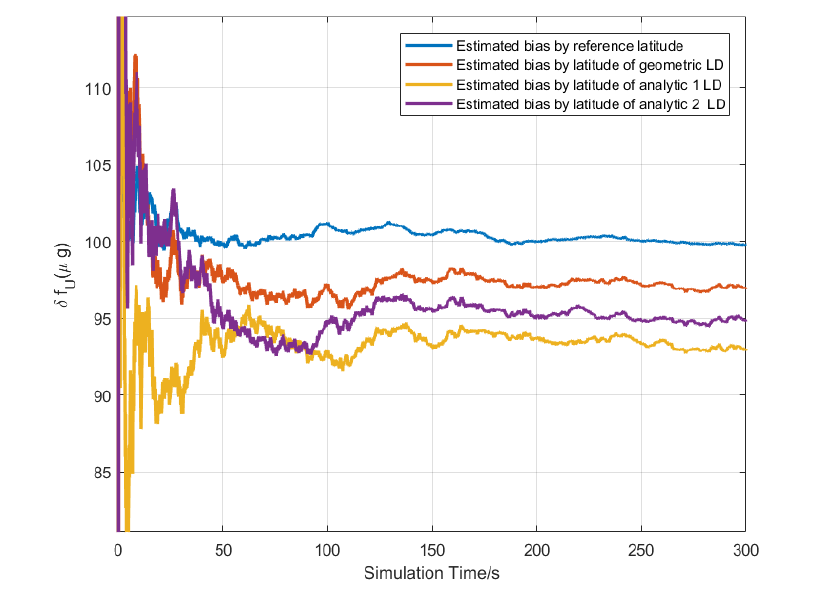
Figure 3. The bias estimation curve of the upward accelerometer by latitude of different LD method.